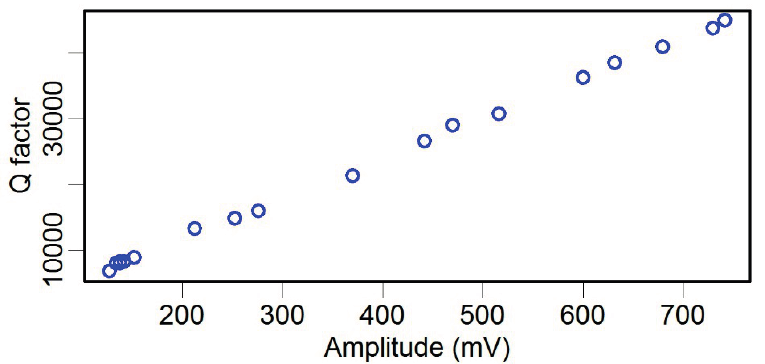
Figure 8. Resonant oscillation amplitude vs. Q factor of the